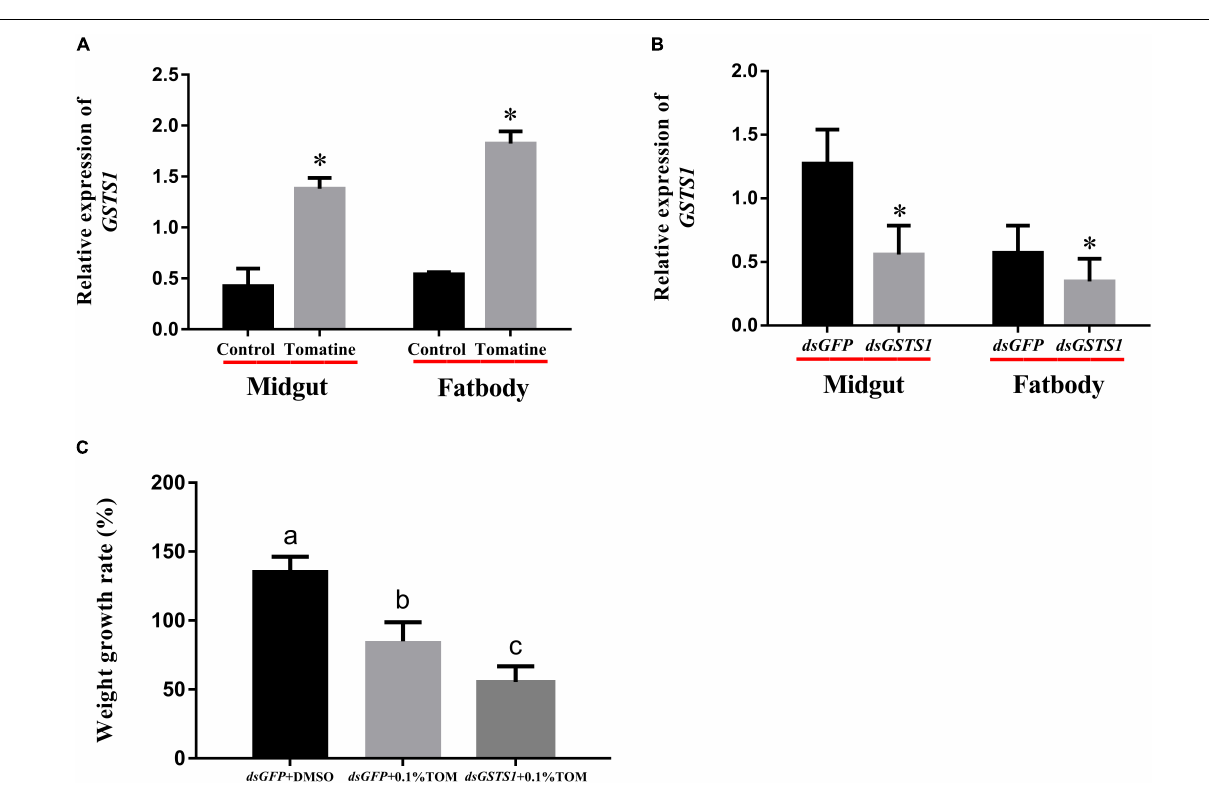
FIGURE 6 | Effect of dsRNA injection on endogenous GSTS1 transcript levels. (A) The effects of TOM treatment on GSTS1 transcript levels were determined by quantitative real-time RT-PCR. (B) Steady-state GSTS1 transcript levels in midgut and fat body tissues were determined by the quantitative real-time RT-PCR analysis of green fluorescent protein dsRNA ( dsGFP ) and GSTS1 dsRNA (ds GSTS1 ) injections into fourth instar S. litura larvae. (C) Effects of dsRNA injection on the weight gain and mortality of S. litura larvae fed TOM. The weight growth rates of S. litura fourth instar larvae fed artificial diets supplemented with tomatine (TOM, 0.05 mg/g) after receiving dsRNA injections at different feed stages were monitored. Data were normalized to the α -actin internal control, and the 2 - (cid:77) (cid:77) Ct method was used to determine the relative expression levels. The results are expressed as the mean ± SE from assays performed in triplicate. Asterisks indicate significant differences ( ∗ p < 0.05). Significant differences among groups are indicated by the letters above each bar ( p < 0.05 according to one-way ANOVA followed by the Duncan’s multiple range test). dsGFP +TOM, green fluorescent protein dsRNA-injected larvae fed artificial diets supplemented with tomatine; ds GSTS1 +TOM, GSTS1 -injected larvae fed artificial diets supplemented with